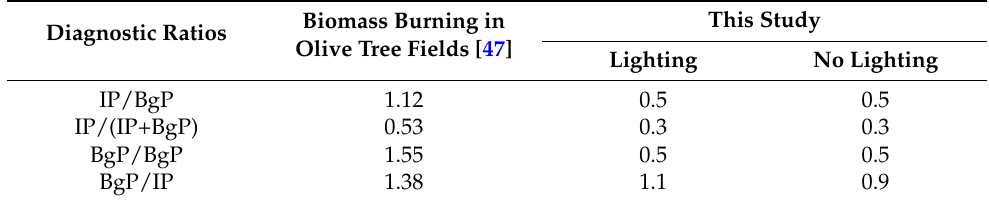
Table 3. The average of diagnostic ratios comparison between this study (lighting and no lighting) and biomass burning in olive trees field.